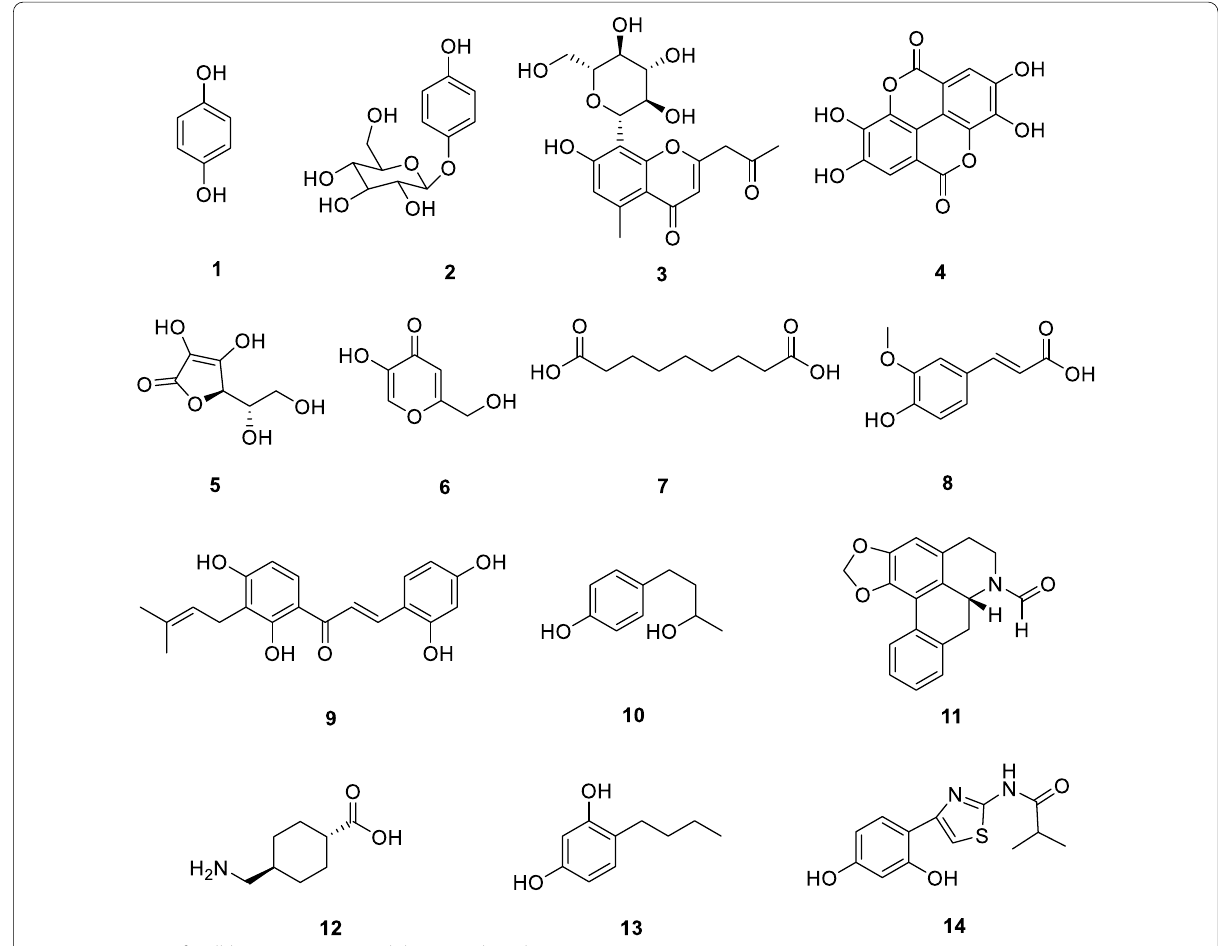
Fig. 2 Structures of well‑known tyrosinase inhibitors as skin whitening